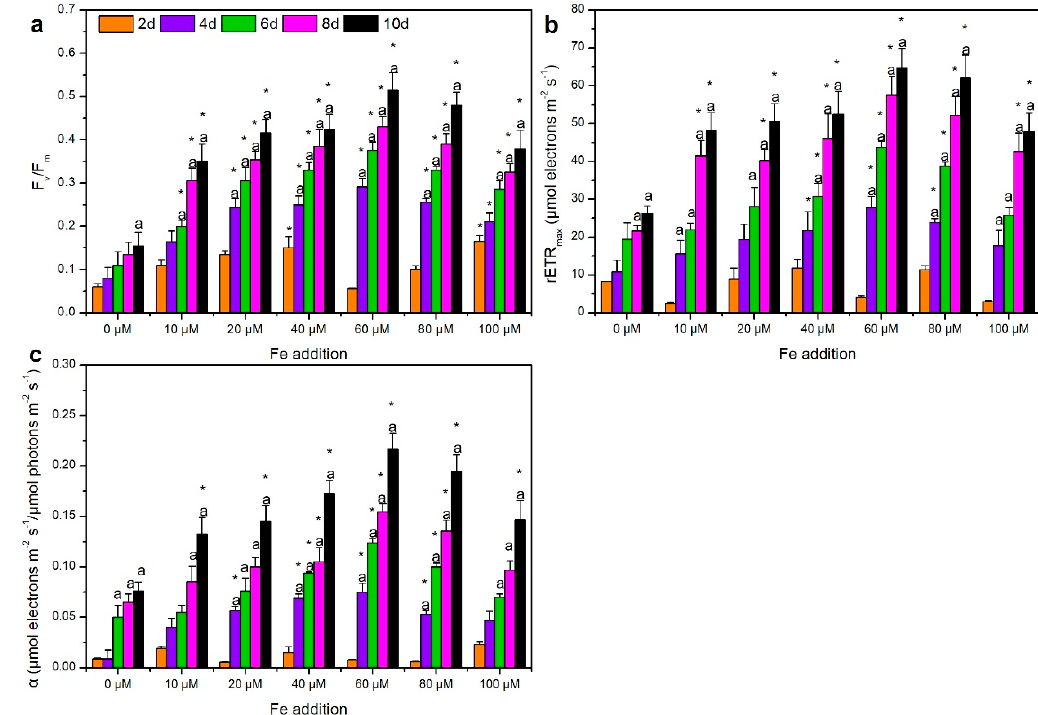
Figure 2. Photosynthetic parameters of M. aeruginosa ( Microcystis aeruginosa ) exposed to different iron concentrations (( a ): F v / F m , maximal quantum yield, dimensionless; ( b ): rETR max , maximal relative electron transport rate, µ mol electrons m − 2 s − 1 ; ( c ): α , photosynthetic efficiency, µ mol electrons m − 2 s − 1 / µ mol photos m − 2 s − 1 ). Error bars represent the standard deviation of triplicate samples. a Significant difference between the sampling day and the 2nd day under the same iron exposure; * Significant difference between the iron addition exposure and the control exposure on the same cultivation day. p < 0.05 was accepted as statistically significant for differences between exposure data.